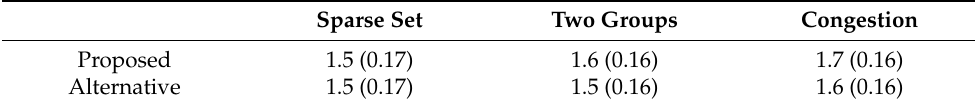
Table 1. Mean number of object attributes with standard error.